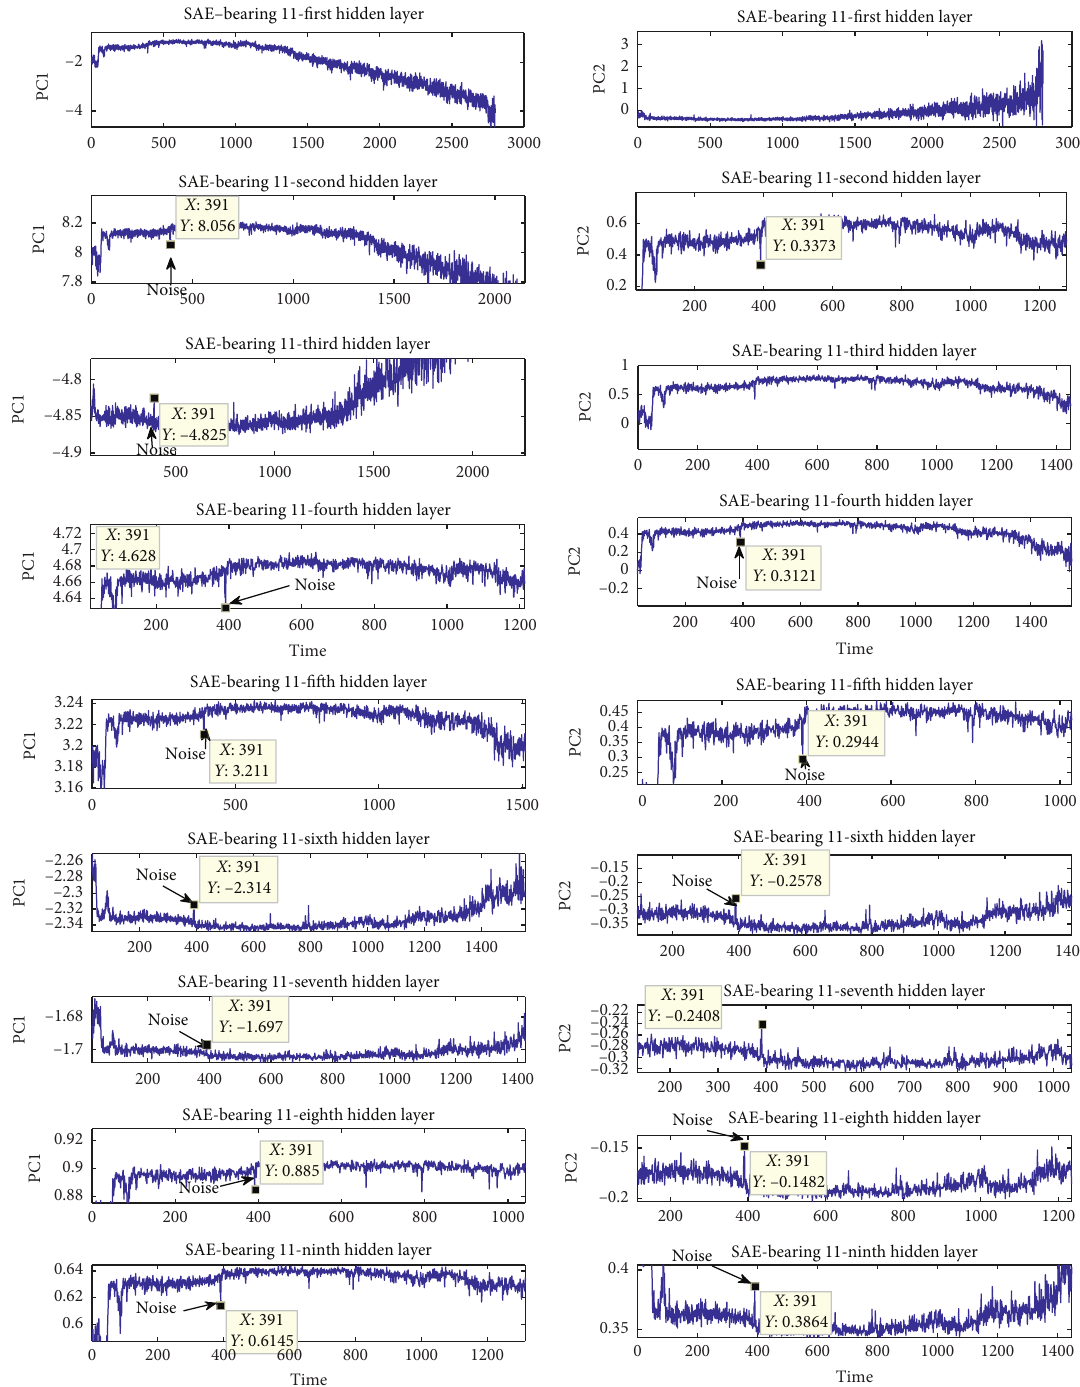
Figure 8: Extracted degradation through every hidden layer for bearing 11 by using the d (2) Compared with the SAE, the selected clustering c and the local density ρ i , the more likely it is to center points with jumping for bearings 13 and 15 in become the cluster center point. Hence, these three Figures 16(c) and 16(e) are more obvious when the points with obvious jumping are selected as the SDAE is used. For example, in Figure 14(c), bearing clustering center points, and there are only two 13 contains three clustering center points, but the points with obvious jumping.